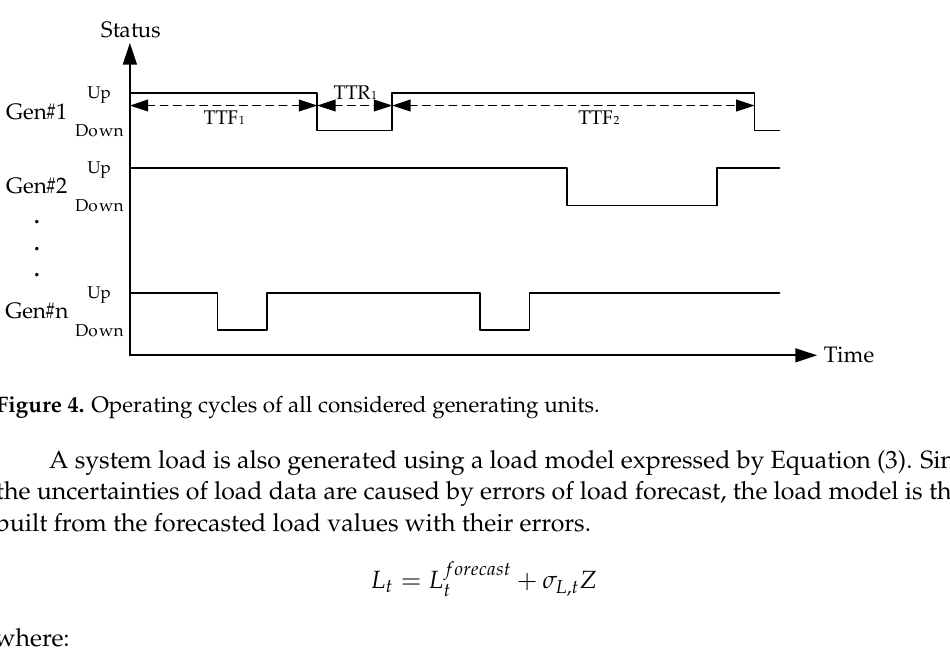
Figure 3. Two-state model for a generating unit.